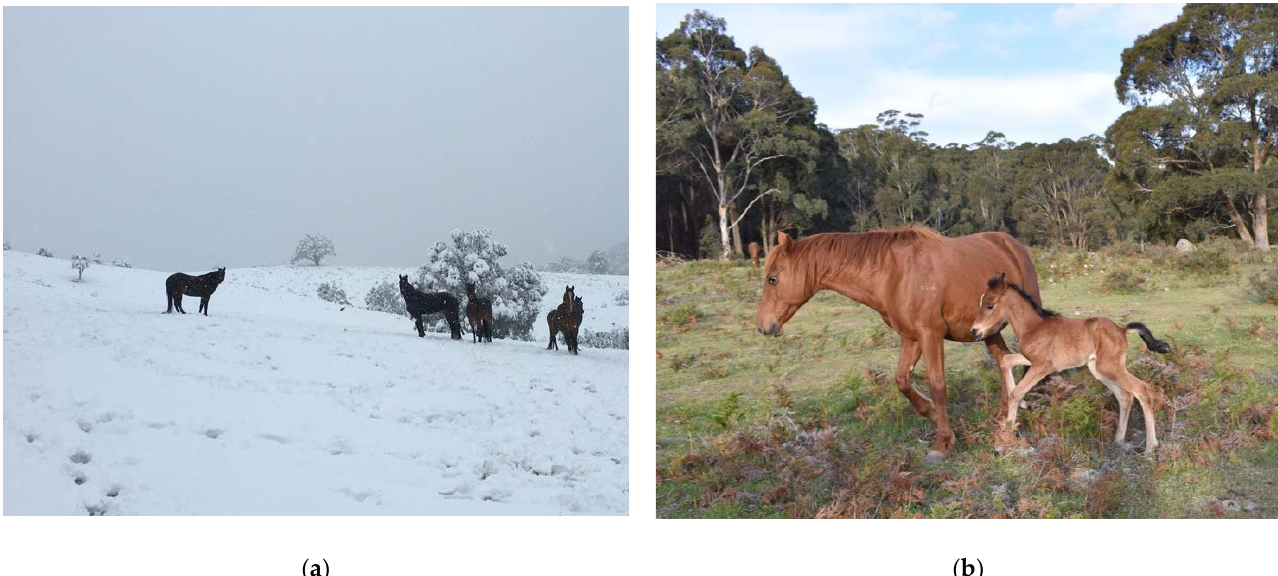
Figure 5. The thermoneutral zone of horses can vary. ( a ) Horses can adapt to different climates and modify their thermoneutral zone. ( b ) Newborn foals have much higher lower critical temperatures [24,109]. Images A. M. Harvey.